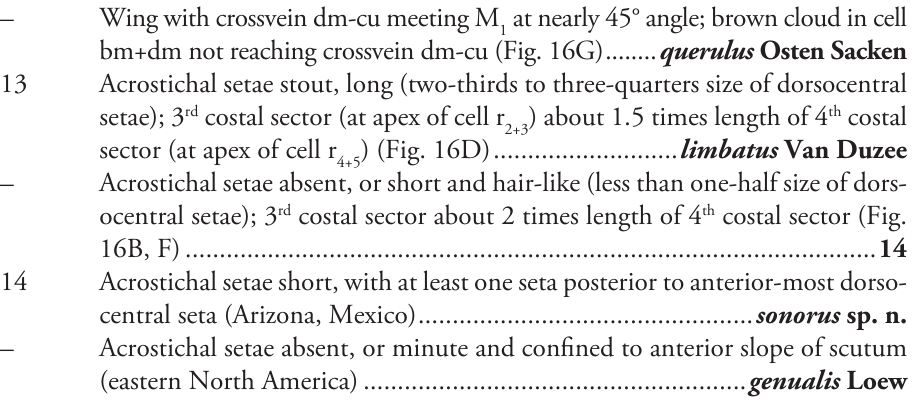
16B, F) ..................................................................................................... 14 Acrostichal setae short, with at least one seta posterior to anterior-most dorso- central seta (Arizona, Mexico) ................................................. sonorus sp. n. (eastern North America) ........................................................ genualis Loew